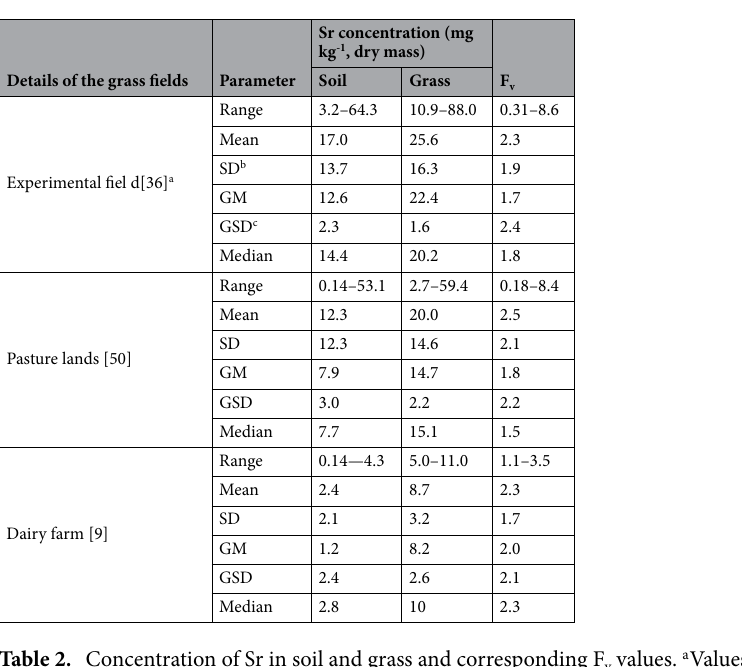
Table 2. Concentration of Sr in soil and grass and corresponding F v values. a Values within square brackets in column 1 represents the number of samples analyzed (soil and grass each). b SD denotes standard deviation. c GSD represents the geometric standard deviation